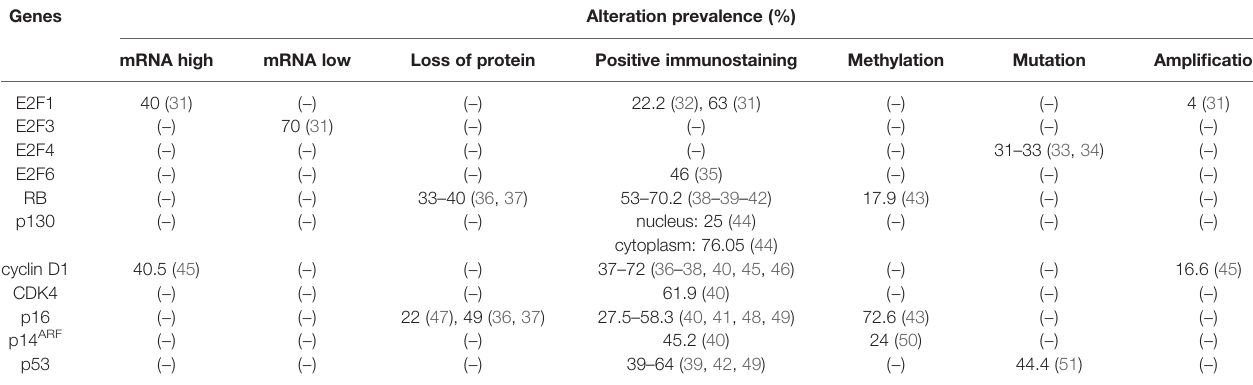
TABLE 1 | Abnormalities in key components of the RB-E2F pathway in patients with GC. Genes mRNA high